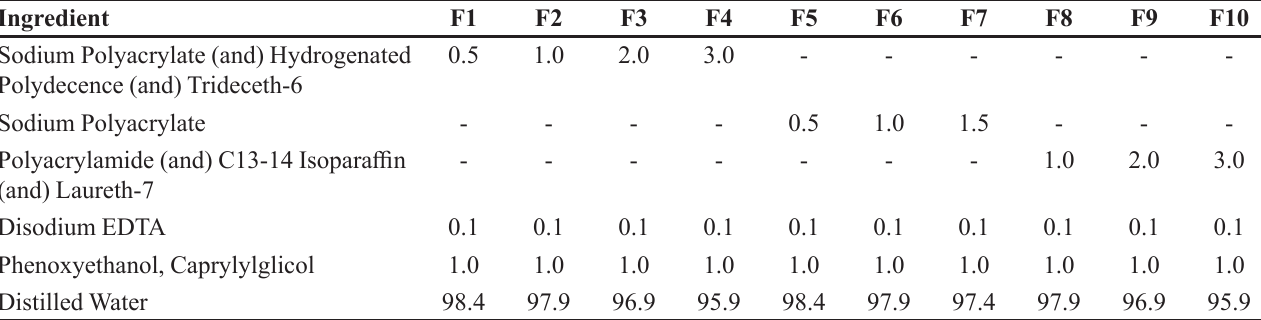
TABLE I - Composition of formulations (% w/w) for incorporation of O. ficus-indica extracts Ingredient Sodium Polyacrylate (and) Hydrogenated Polydecence (and) Trideceth-6 Polyacrylamide (and) C13-14